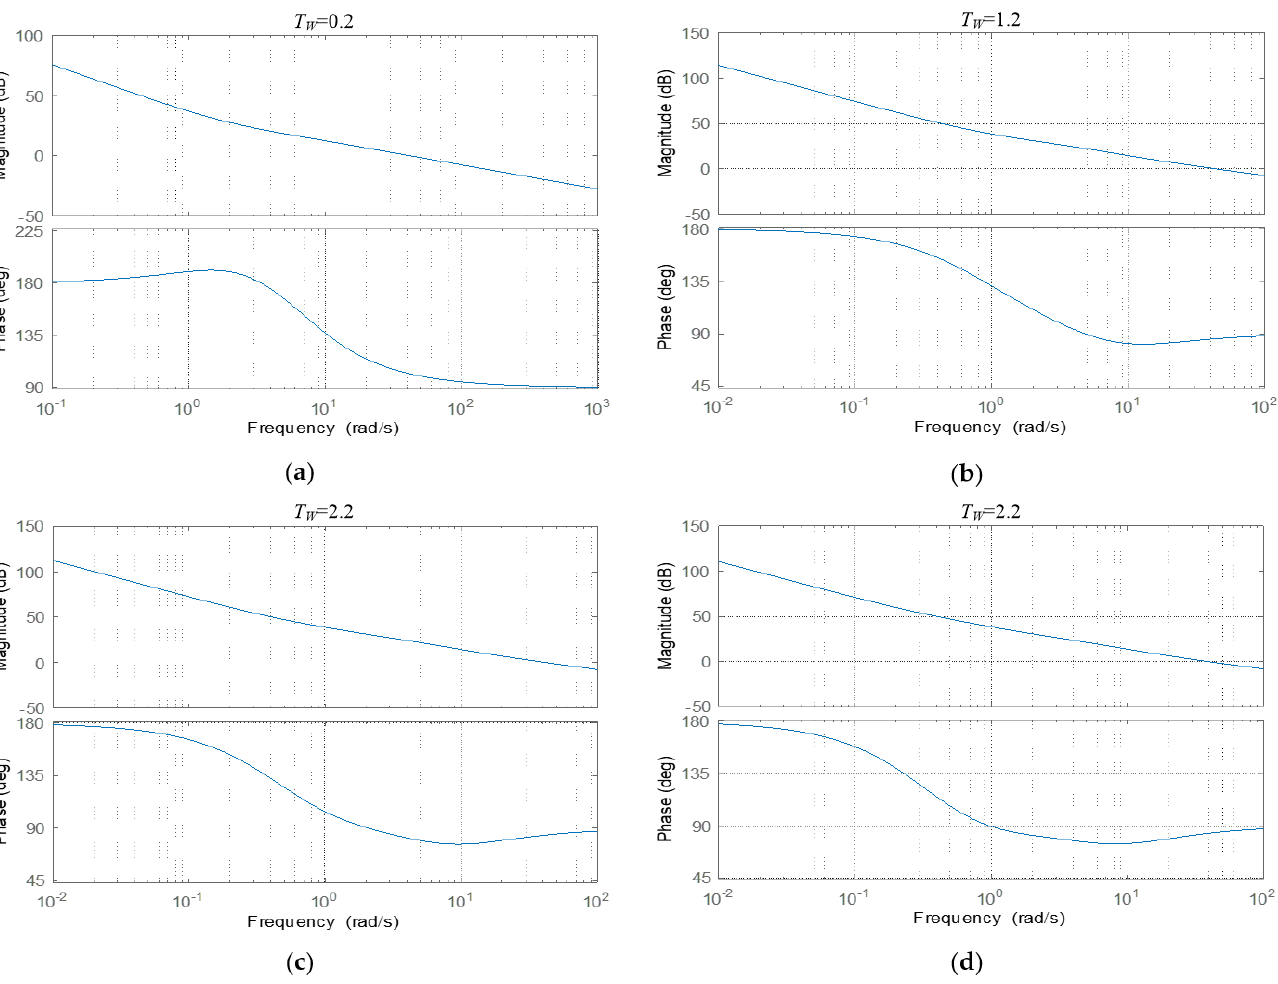
Figure 4. Bode graphs of G Pm ( s ) with different T W : ( a ) T W = 0.2; ( b ) T W = 1.2; ( c ) T W = 2.2; ( d ) T W = 3.2.